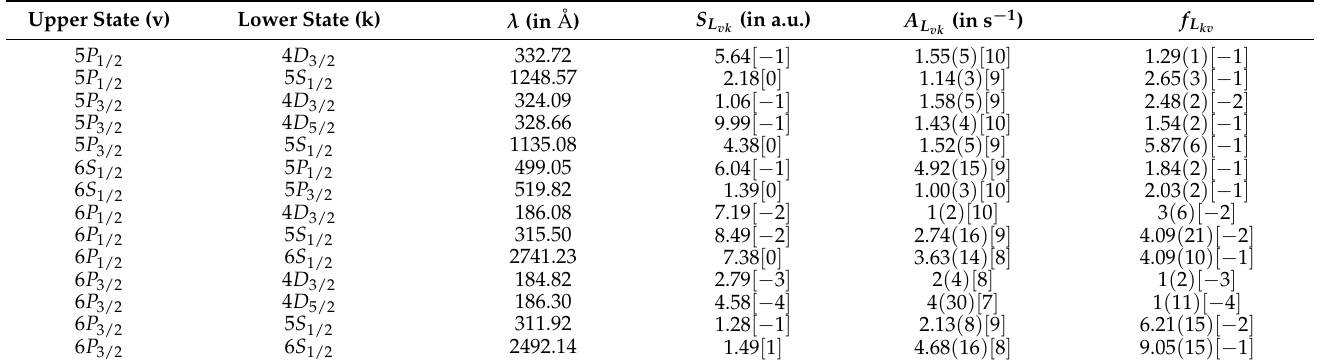
Table 3. The L-gauge line strengths ( S L ( A L ) in (s − 1 ) and absorption oscillator strengths ( f L vk Values in square brackets represent the order of 10. Uncertainties are given in parentheses.